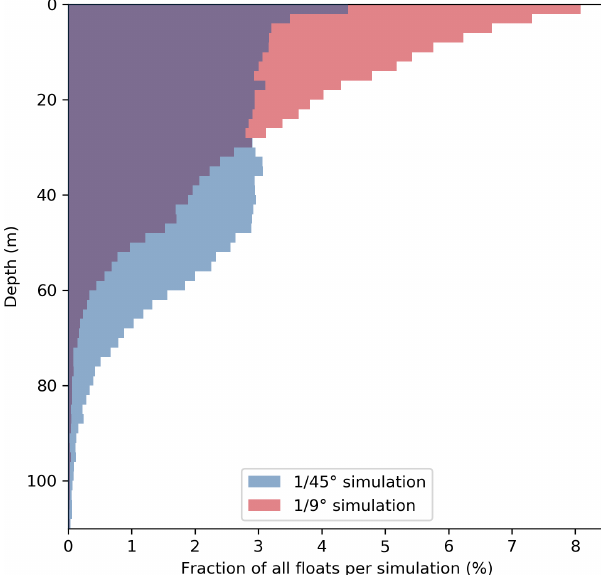
Figure 7. Vertical distribution of all upwelled floats from the float experiment ensemble 20d after upwelling in the 1 / 9 and 1 / 45 ◦ sim- ulations. Histograms were generated using 2m vertical